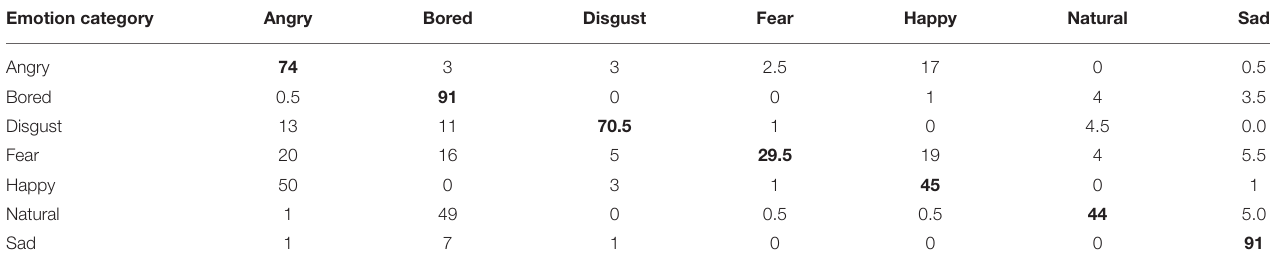
TABLE 4 | Recognition rate of ILSTM in Emo-DB.